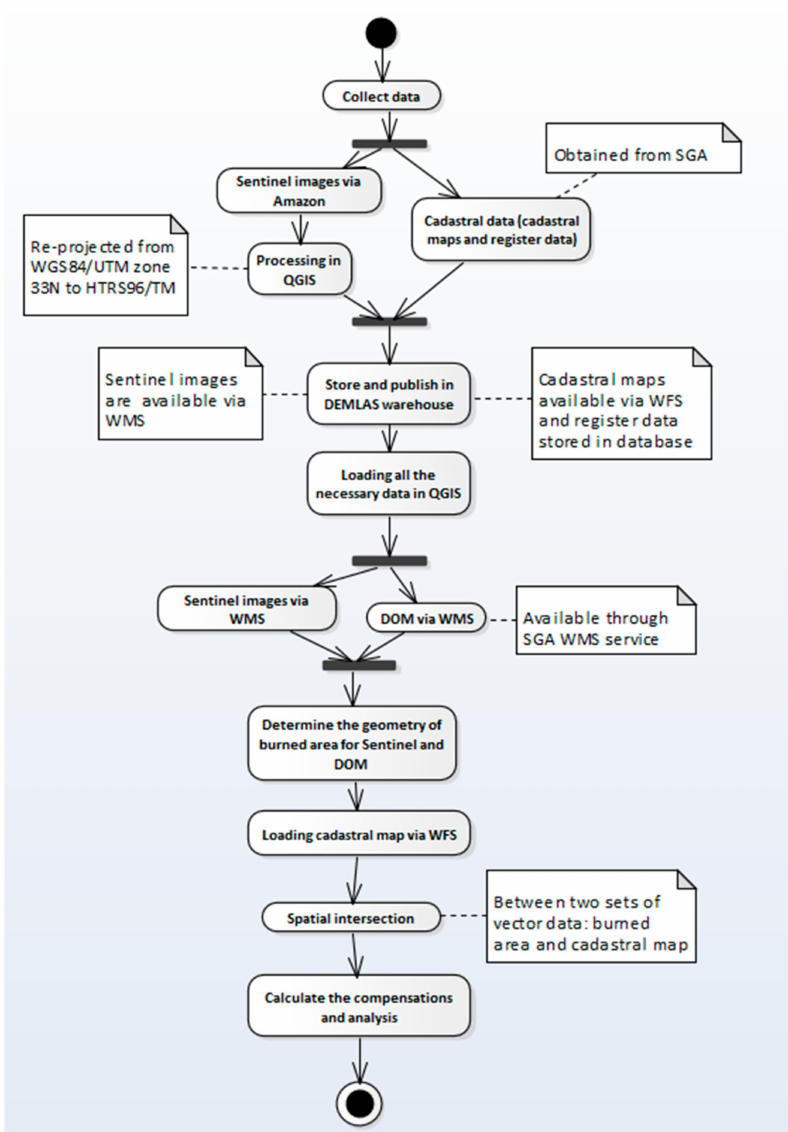
Figure 2. Methodology of hazard